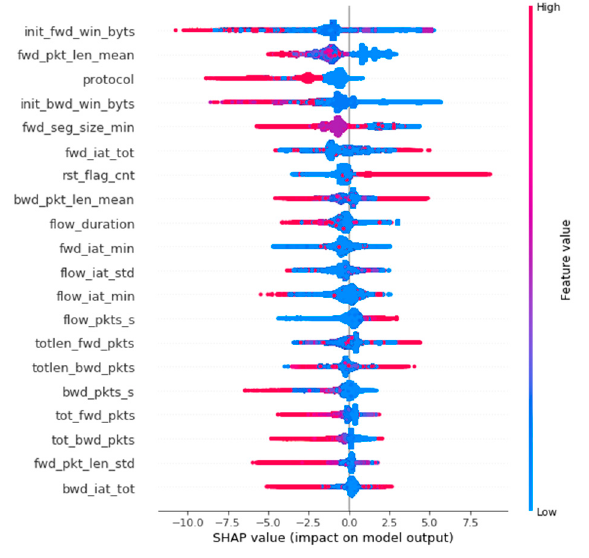
Figure 10. Feature importance.